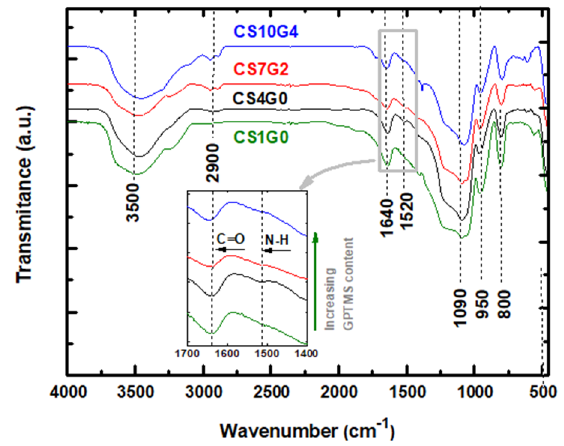
Figure 4. FTIR spectra of CS1G0, CS4G0, CS7G2 and CS10G4 hybrid aerogel samples.